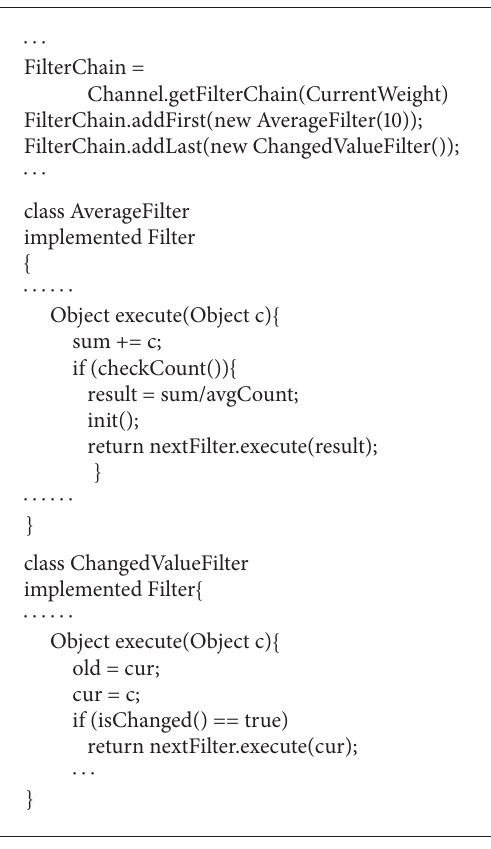
Algorithm 2: Example of filter